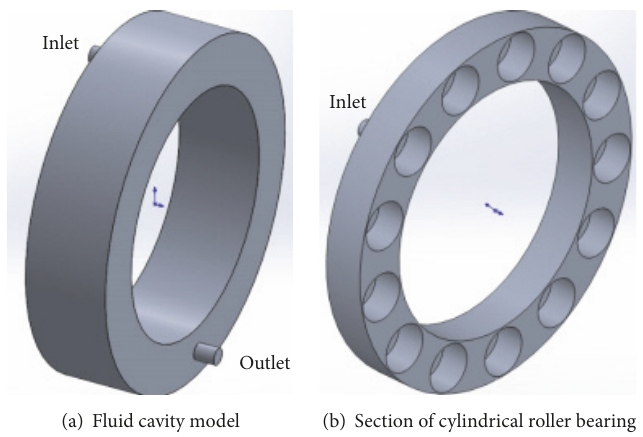
Figure 2: The fluid domain in the cylindrical roller bearing.